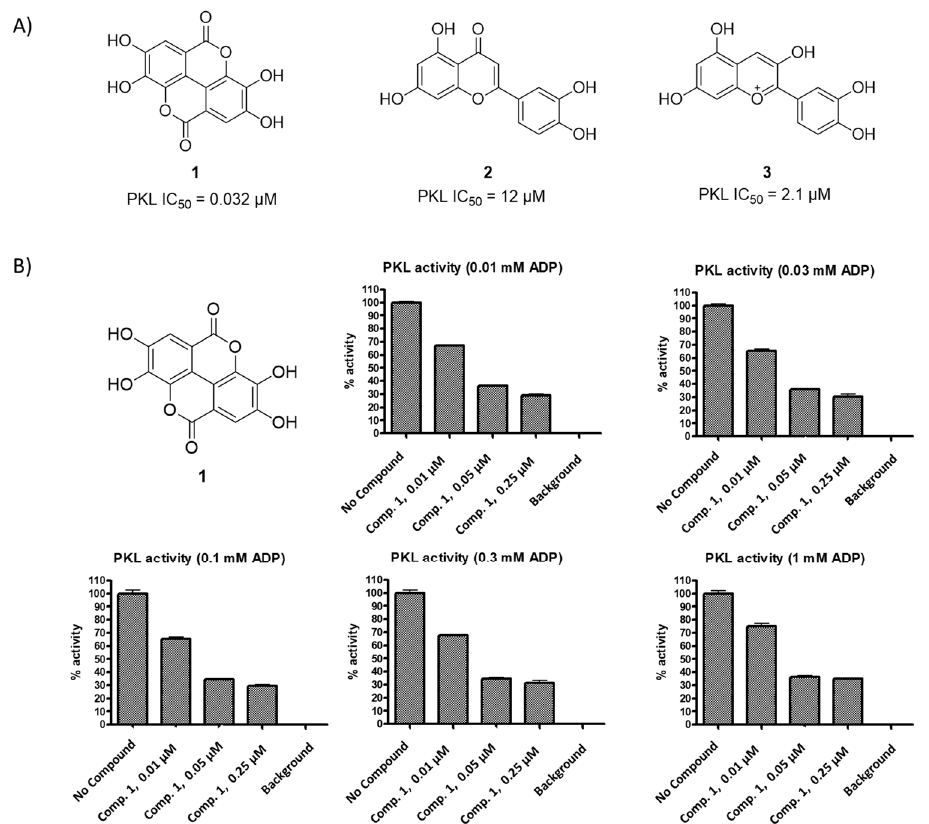
Figure 1. ( A ) Polyphenols exhibiting PKL inhibition. Ellagic acid (EA, 1 ), luteolin ( 2 ), cyanidin ( 3 ). ( B ) Inhibition of PKL by compound 1 at different concentrations of the substrate ADP.